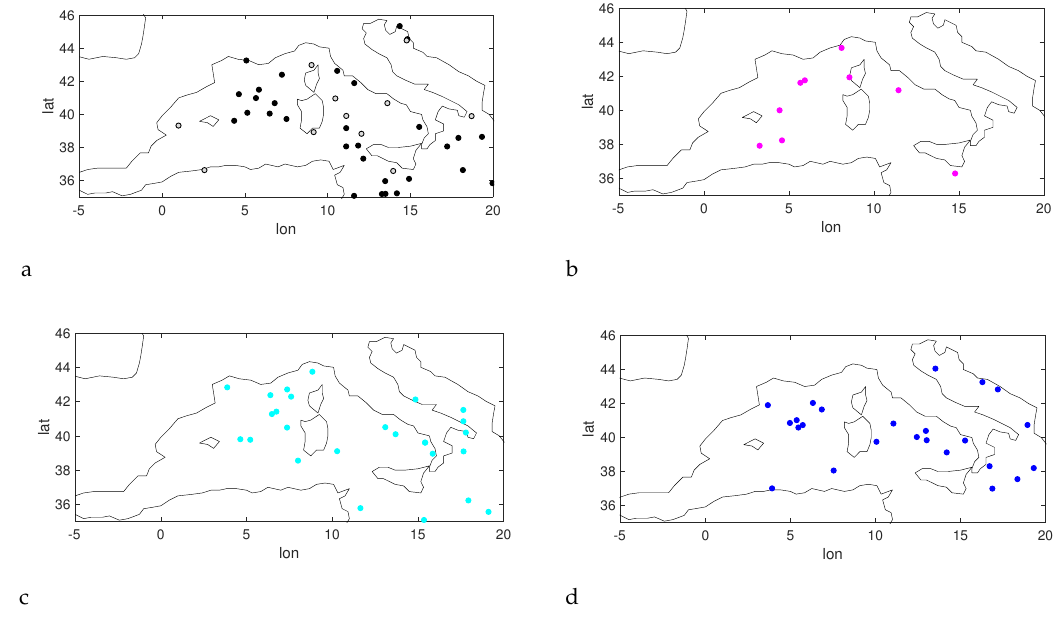
Figure 5. Location of the first transition to Medicane state for the et04 ( a ), bt11 ( b ), kt11 ( c ) and kw11 ( d ) simulations, for G = 3.21 × 10 − 2 hPa km − 1 . In ( a ) the black dots correspond to events in the period